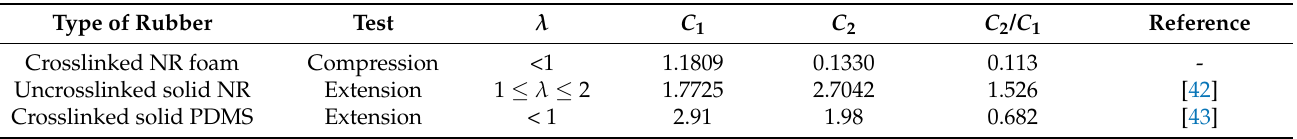
Table 3. Constant values C 1 and C 2 from the Mooney–Rivlin equation [17] at different compression or extension limits ( λ ) of various rubber samples.